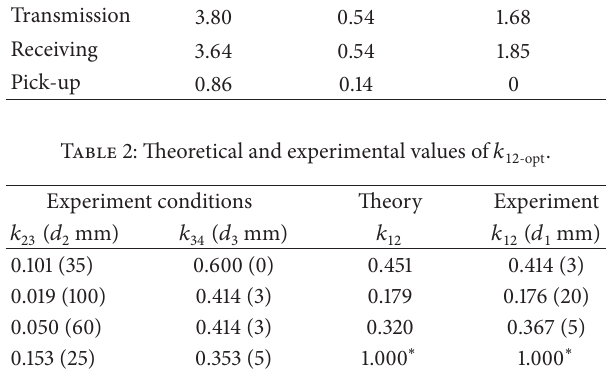
Table 3: Theoretical and experimental values of 𝑘 34